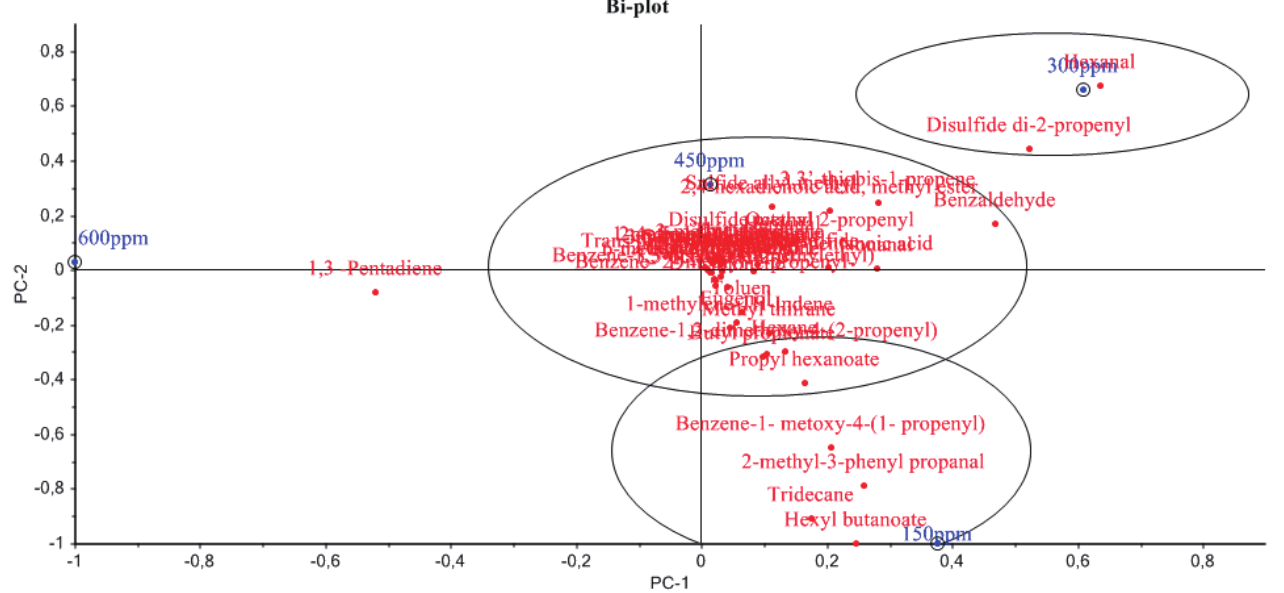
Figure 1. Principal component analysis of the volatile compounds of pastırma produced with different nitrate levels. Principal component1 (PC-1); principal component 2